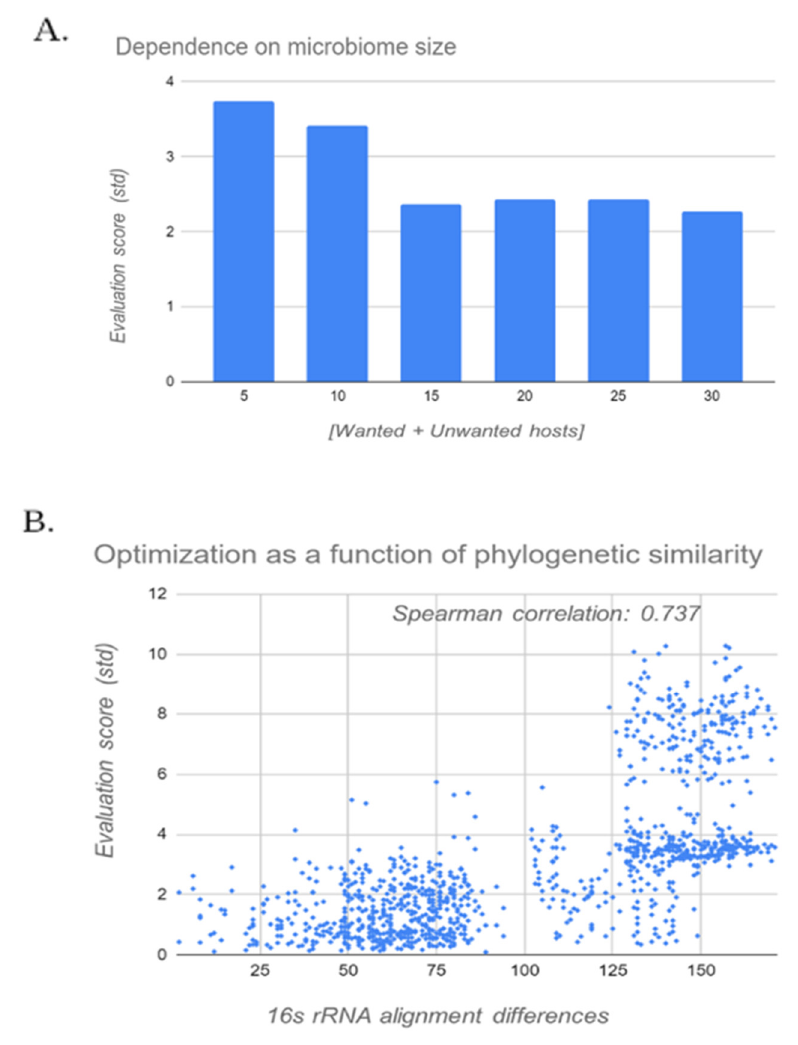
Figure 11. Final test of algorithm resolution and scale up: ( A ) examines 10 random splits of chosen sizes, averaged; and ( B ) shows the correlation between the performance of the model and the evolutionary distance between a pair of species (defined as the number of differences in the alignments of the 16S rRNA sequences).